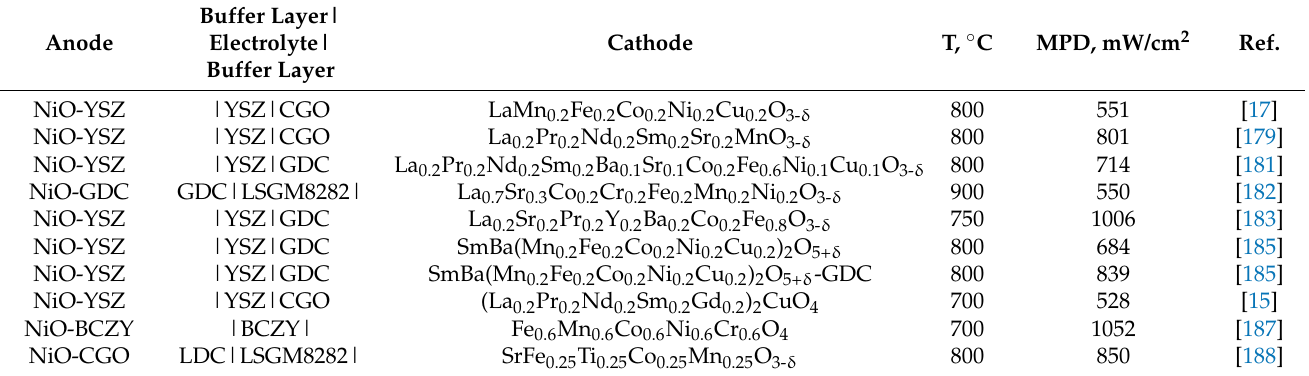
Table 1. Performances of SOFCs with electrodes based on high- and medium-entropy